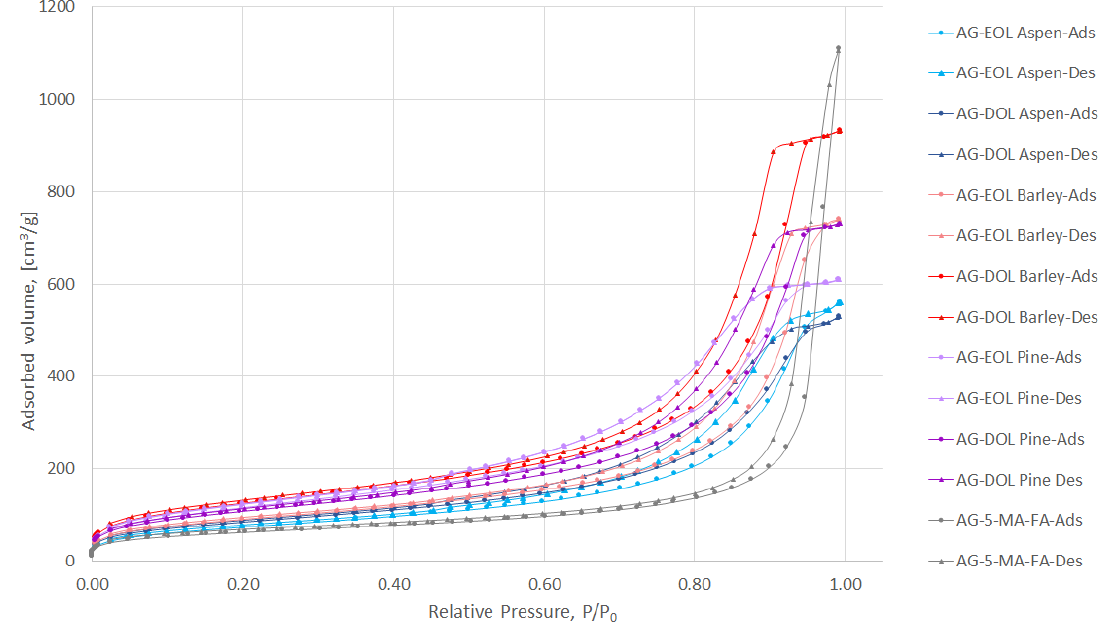
Figure 6. N 2 adsorption/desorption isotherms of lignin-based (75% of the 5-MR was replaced by lignin) and 5-MR-FA aerogels.